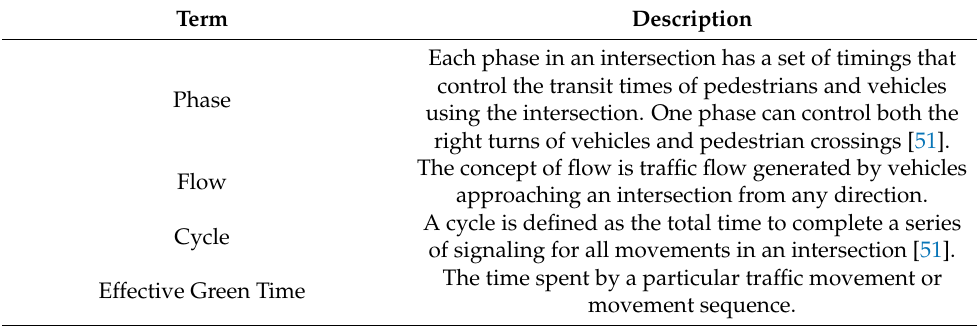
Table 8. Example dataset collected from sensors of the intersections equipped with intrusive sensors.